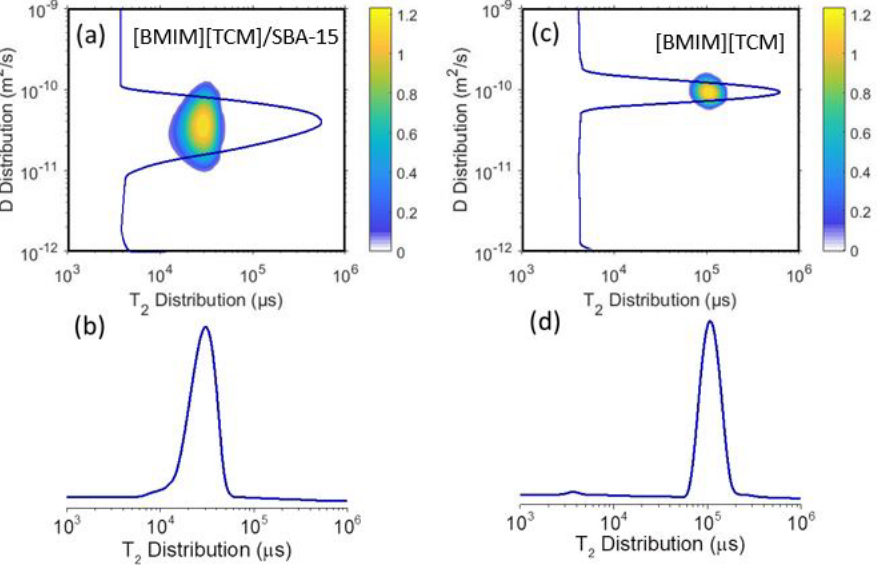
Figure 3. ( a , c ) 2D 1 H NMR D-T 2eff contour plots of the bulk ionic liquid and confined [BMIM] + [TCM] − ionic liquid in SBA-15 at 292 K. ( b , d ) Distribution of the T 2eff values obtained from the 2D contour plots.